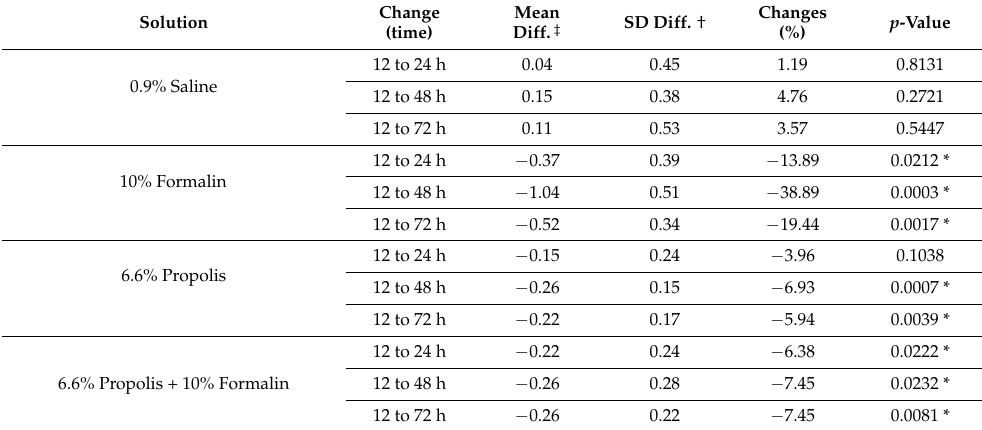
Table 5. Within-group comparisons at different time points for each solution by